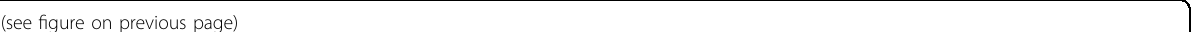
Fig. 6 SIRT2 decreases C/EBP β ubiquitination and stabilizes C/EBP β protein by deacetylation under ethanol stress. a Immuno fl uorescence analysis of SIRT2 and C/EBP β in AML12 cells treated with EtOH (scale bar, 50 μ m). b Endogenous SIRT2 – C/EBP β interaction was analyzed by the amount of C/EBP β coimmunoprecipitated with the same loading amount of SIRT2 in AML12 cells. c Acetylation levels of the same loading amount of endogenous C/EBP β puri fi ed by IP in ethanol-treated AML12 cells detected by pan-acetyllysine antibody are shown, which indicates SIRT2 deacetylates C/EBP β . d , e Acetylation levels of IP-puri fi ed Flag-C/EBP β in HEK293T cells coexpressing SIRT2, SIRT2-H187A ( d ) or with SIRT2 knockdown ( e ). f , g qRT-PCR ( f ) and Western blot analysis ( g ) of C/EBP β expression in SIRT2 knockdown or control AML12 cells treated with or without ethanol. h , i HEK293T cells co-transfected Flag-tagged C/EBP β with the indicated plasmids or siRNA were treated with 10 μ M MG132 or DMSO for 6 h. Ubiquitination level of C/EBP β was probed by anti-HA antibody. j Ubiquitination levels of the same loading amount endogenous C/EBP β puri fi ed by IP were probed by pan-ubiquitin antibody. k Acetylation levels of IP-puri fi ed C/EBP β and its mutants in HEK293T cells with SIRT2 knockdown. K98R